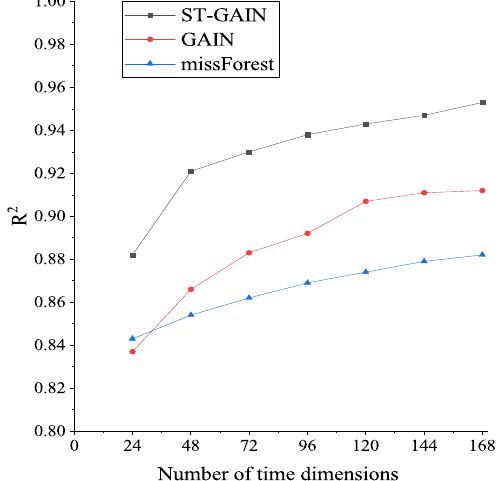
Figure 14. R 2 for different time